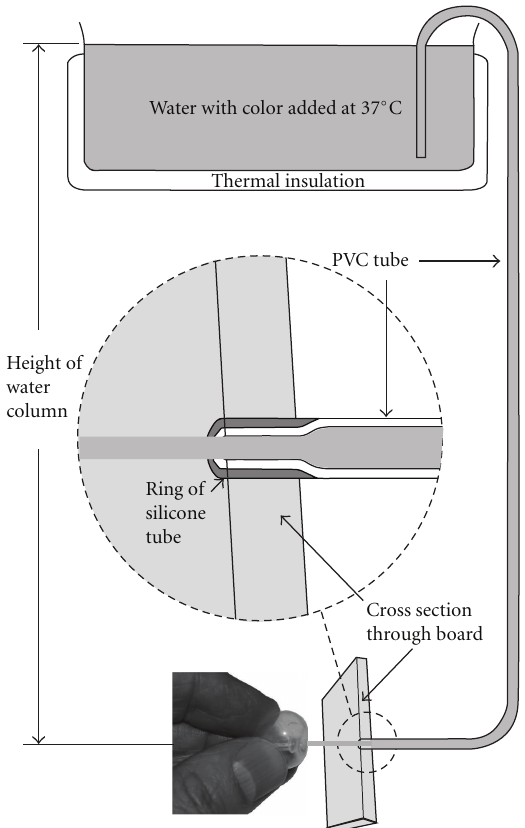
Figure 2: Experimental setup. The PVC tube can be opened and closed using a clamp (not shown). In the depiction, the balloon of the modified Foley catheter is held in front of the orifice while tap water spouts out. The balloon is ready to be pressed against the